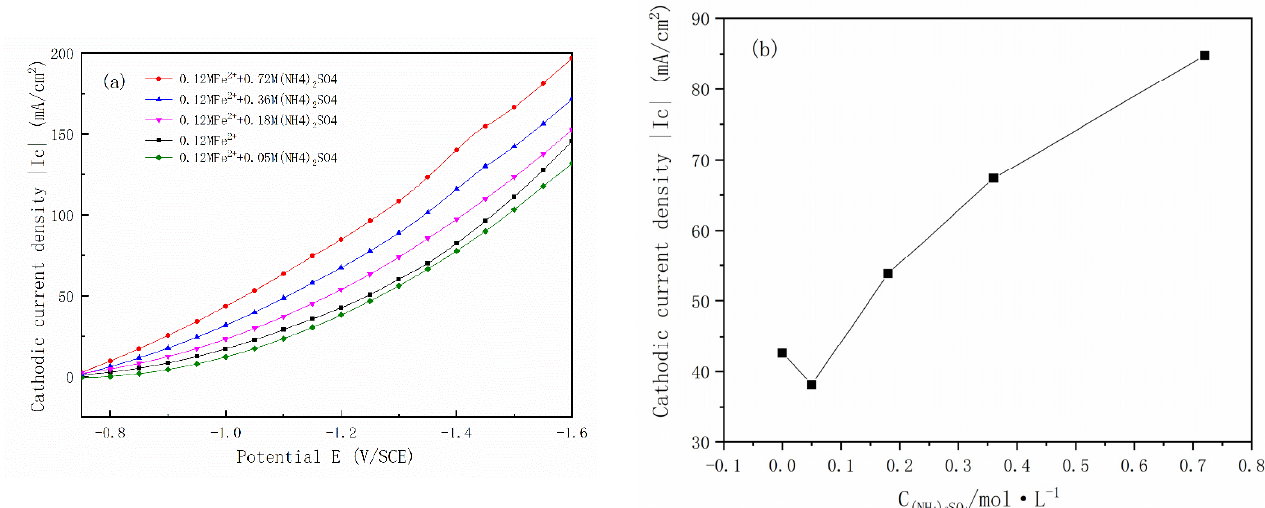
Figure 4. ( a ) Cathodic polarization curves measured in solutions with di ff erent (NH 4 ) 2 SO 4 concen- trations with 0.12 M Fe 2+ ; ( b ) the corresponding cathodic current density |Ic| at a potential of − 1.2 V.